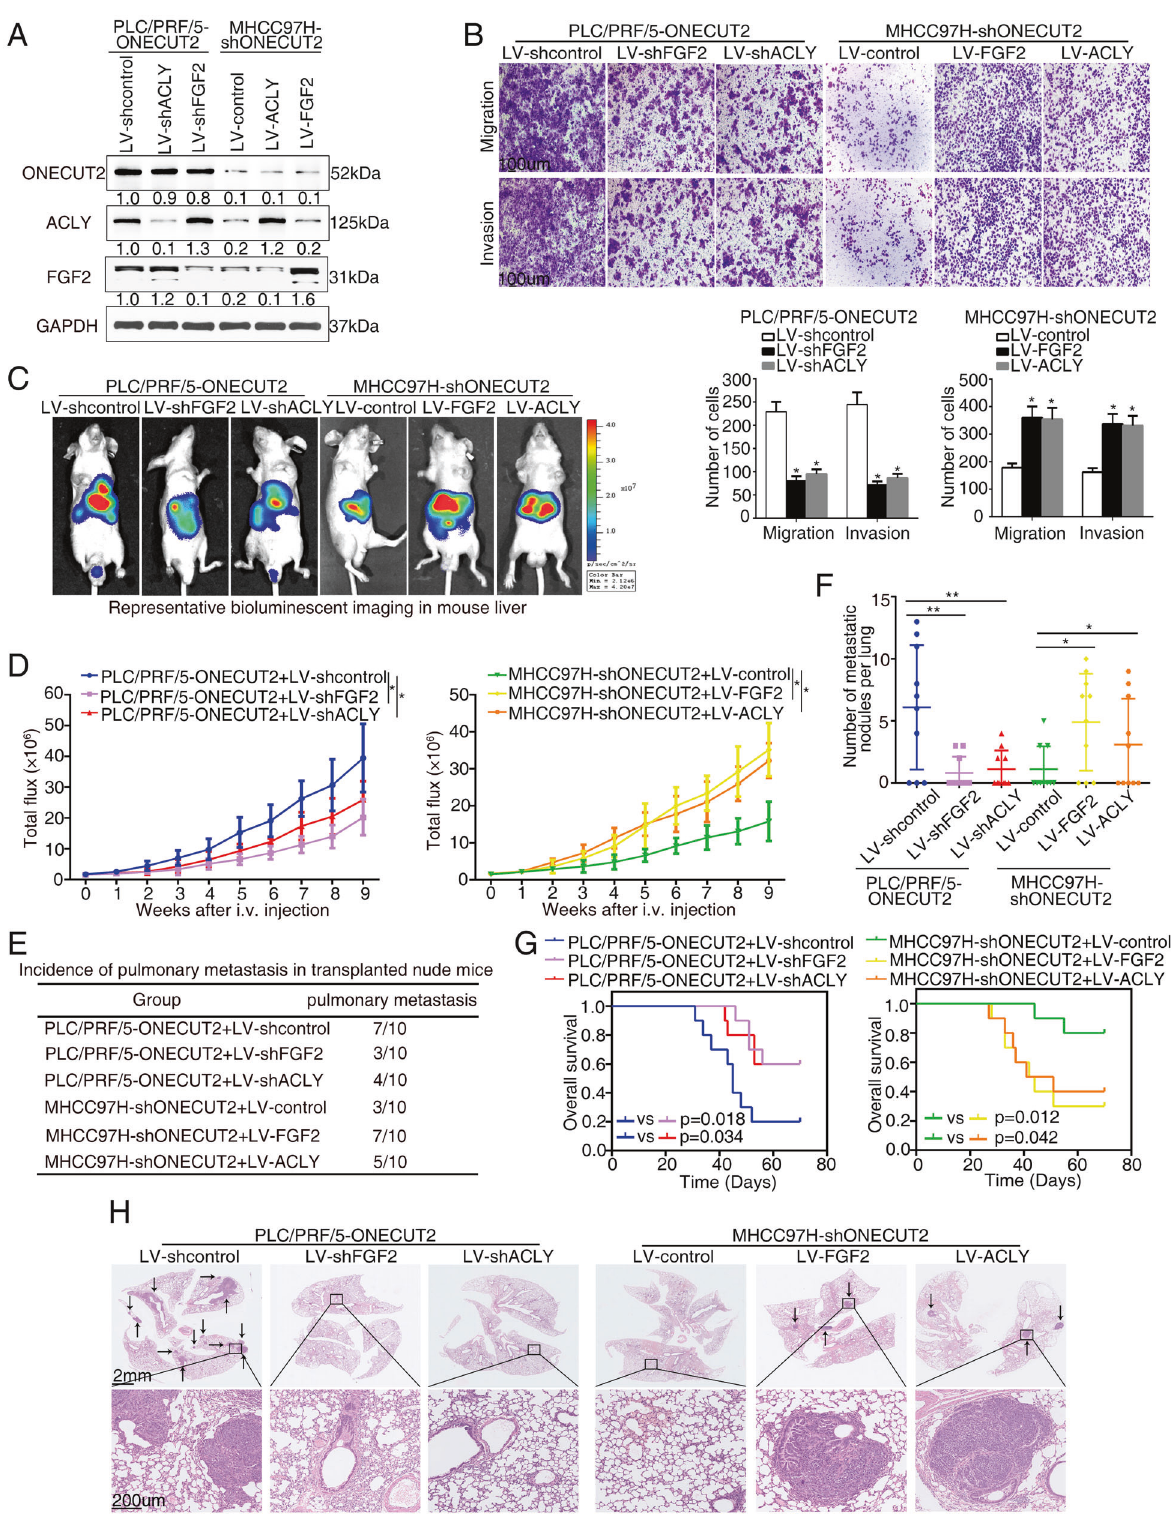
Fig. 4 ONECUT2 promotes HCC metastasis by upregulating FGF2 and ACLY. A Protein levels of ONECUT2, FGF2, and ACLY were measured in PLC/PRF/5 cells cotransfected with ONECUT2-overexpressing lentivirus and FGF2-silencing or ACLY-silencing lentivirus and MHCC97H cells cotransfected with ONECUT2-silencing lentivirus and FGF2-overexpressing or ACLY-overexpressing lentivirus by western blotting. B Knockdown of FGF2 or ACLY was performed in ONECUT2-overexpressing PLC/PRF/5 cells, and overexpression of FGF2 or ACLY was performed in ONECUT2-silencing MHCC97H cells. Next, transwell assays were performed. C – H ONECUT2 facilitated HCC metastasis by inducing FGF2 and ACLY. Representative bioluminescent imaging ( C ), bioluminescent signals ( D ), the incidence of pulmonary metastasis ( E ), number of pulmonary metastasis foci ( F ), overall survival ( G ), and H&E staining of the lungs ( H ) among four groups with ten mice in each group 9 weeks after orthotopic implantation of the indicated cells. Data are mean ± SD. * P < 0.05, ** P < 0.01. Cell Death and Disease (2021)